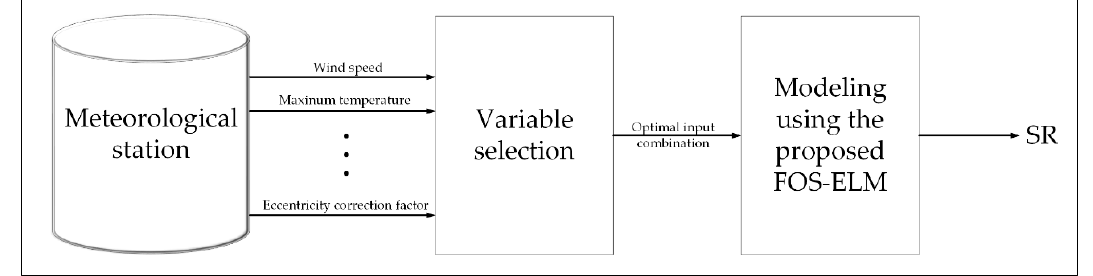
Figure 3. Main frame of the proposed variable forgetting factor (FOS-ELM) for solar radiation prediction.